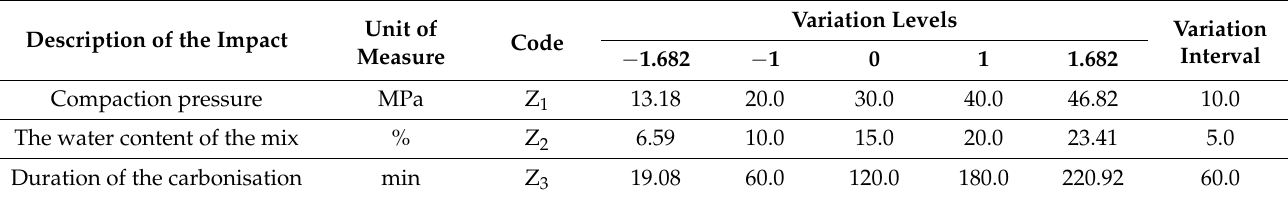
Table 3. The conditions for planning the experiment.